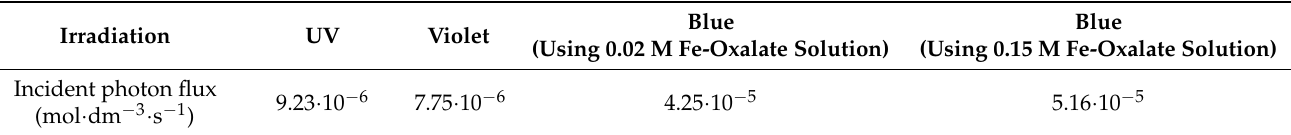
Table 2. Incident photon fluxes determined by potassium ferrioxalate actinometry. Table 3. Incident photon fluxes under green, yellow, and red irradiation obtained from the Irradiation